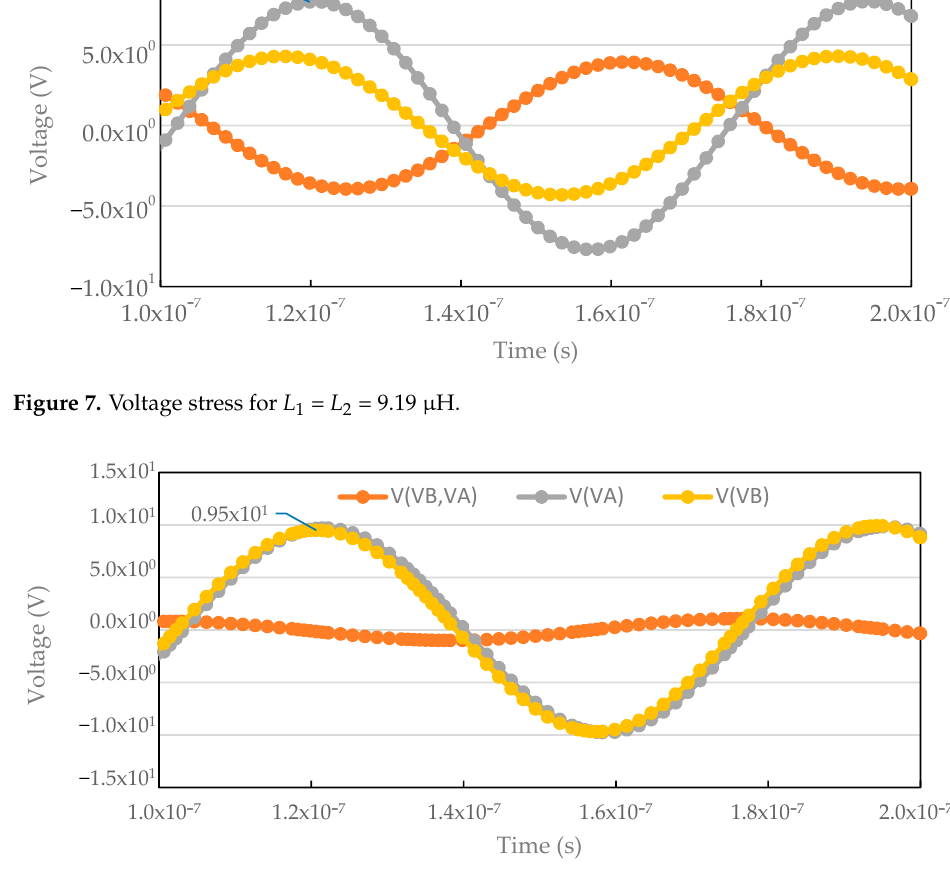
µ Figure 8. Voltage stress for L 1 = L 2 = 13.62 µH. Figure 8. Voltage stress for L 1 = L 2 = 13.62 µH. Figure 8. Voltage stress for L 1 = L 2 = 13.62